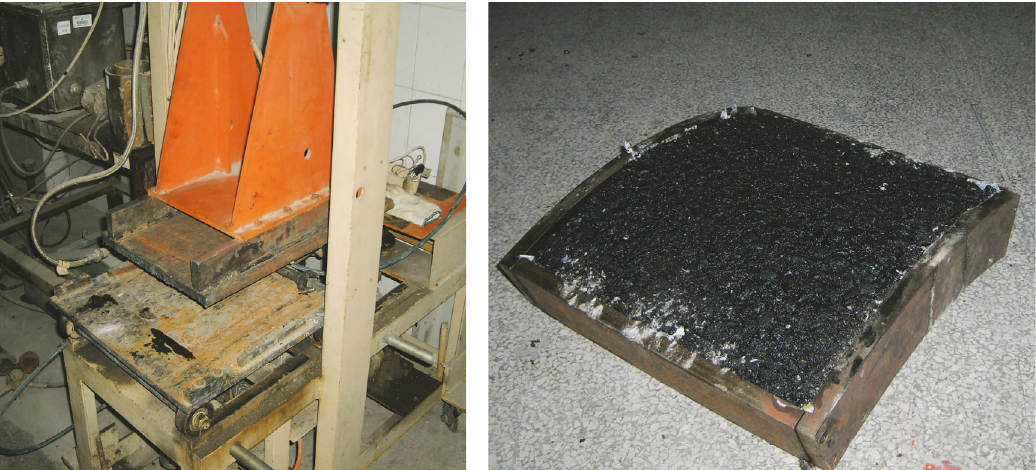
Figure 5: Flat head roller and compacted specimen.